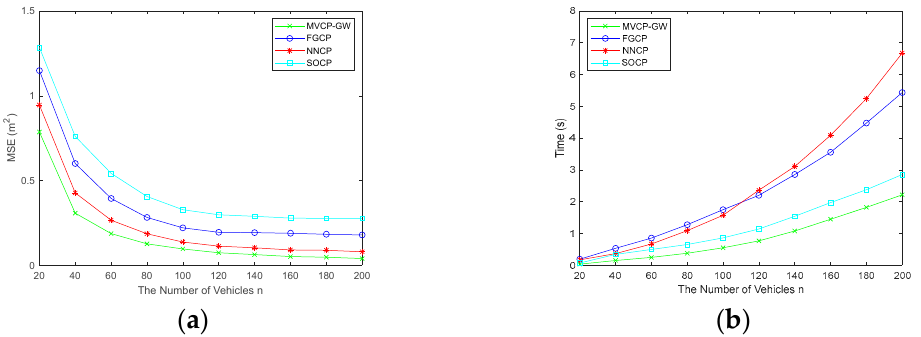
Figure 5. Simulation results of algorithm performance changing with vehicle distribution density: ( a ) the relation diagram of positioning error MSE with the increase of the number of vehicles n; ( b ) the relation diagram of positioning time 𝑡 (cid:3028)(cid:3039)(cid:3039) with the increase of the number of vehicles n.